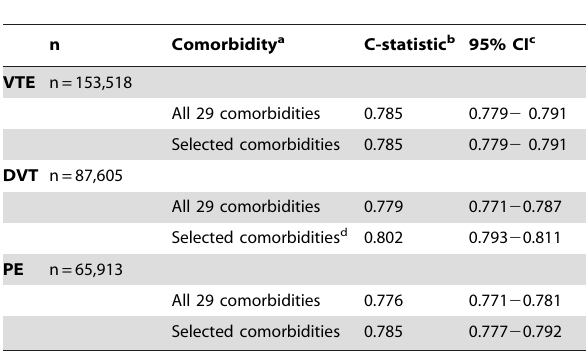
Table 3. Predictive accuracy of AHRQ 29-comorbidity index for in-hospital death among adult hospitalizations with